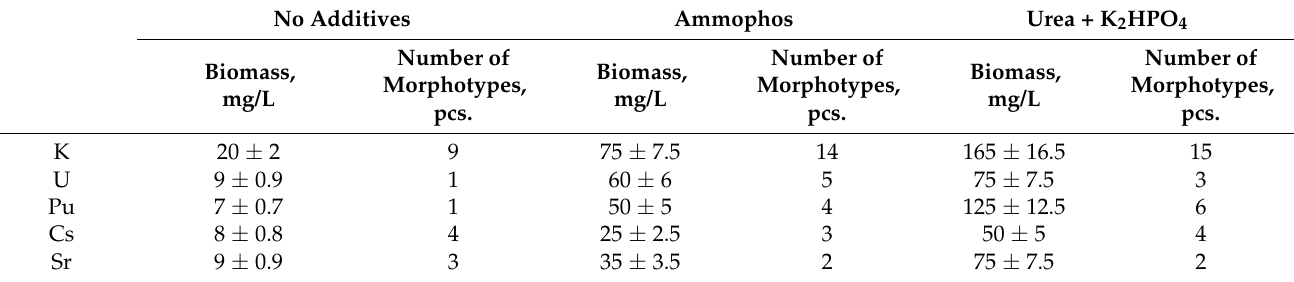
Table 4. Increase in phytoplankton biomass after adding stimulant additives.